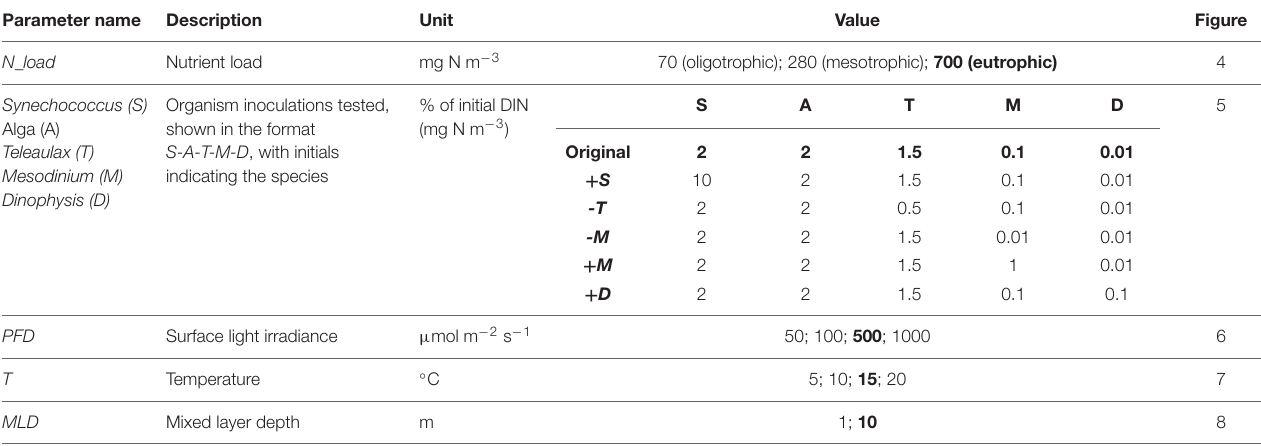
TABLE 4 | Abiotic parameters of the model were varied in the